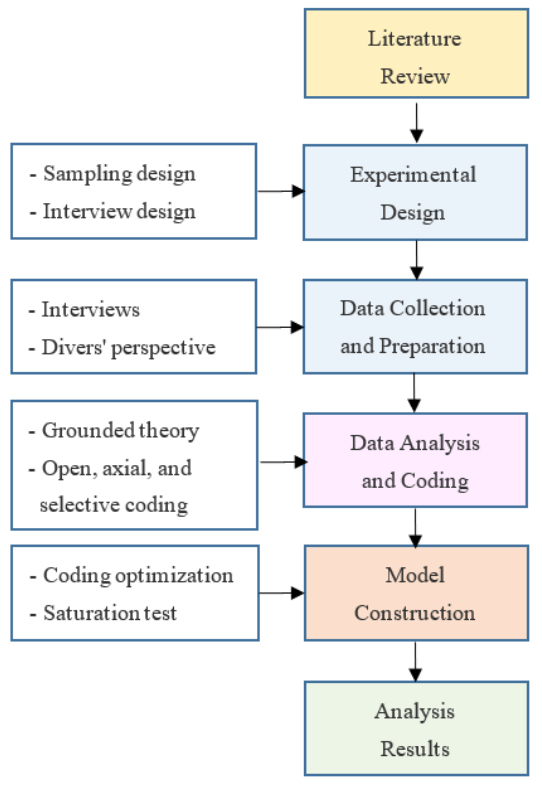
Figure 1. Study methodology.